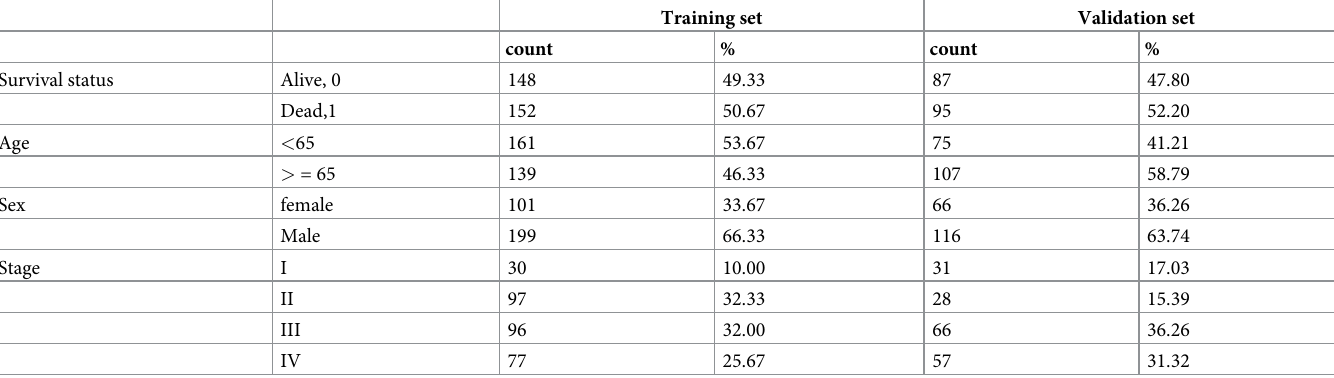
Table 1. Clinical characteristics of patients with gastric cancer.